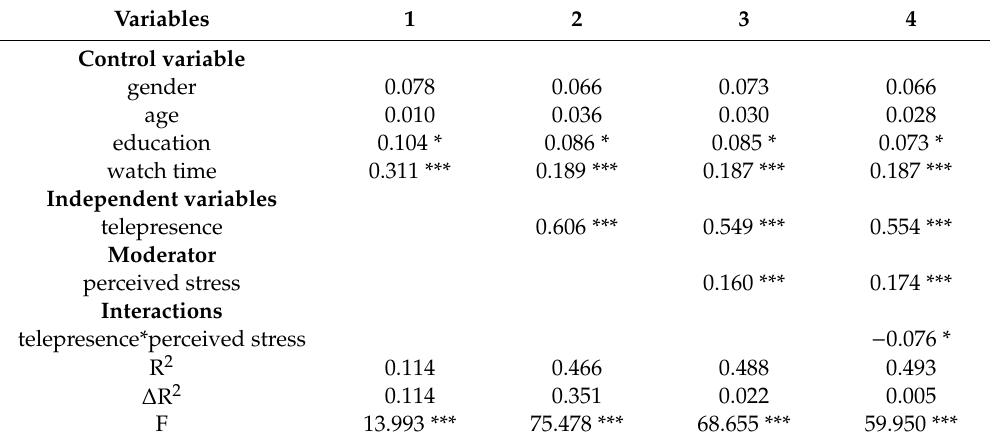
Table 6. Perceived stress, telepresence and flow experience